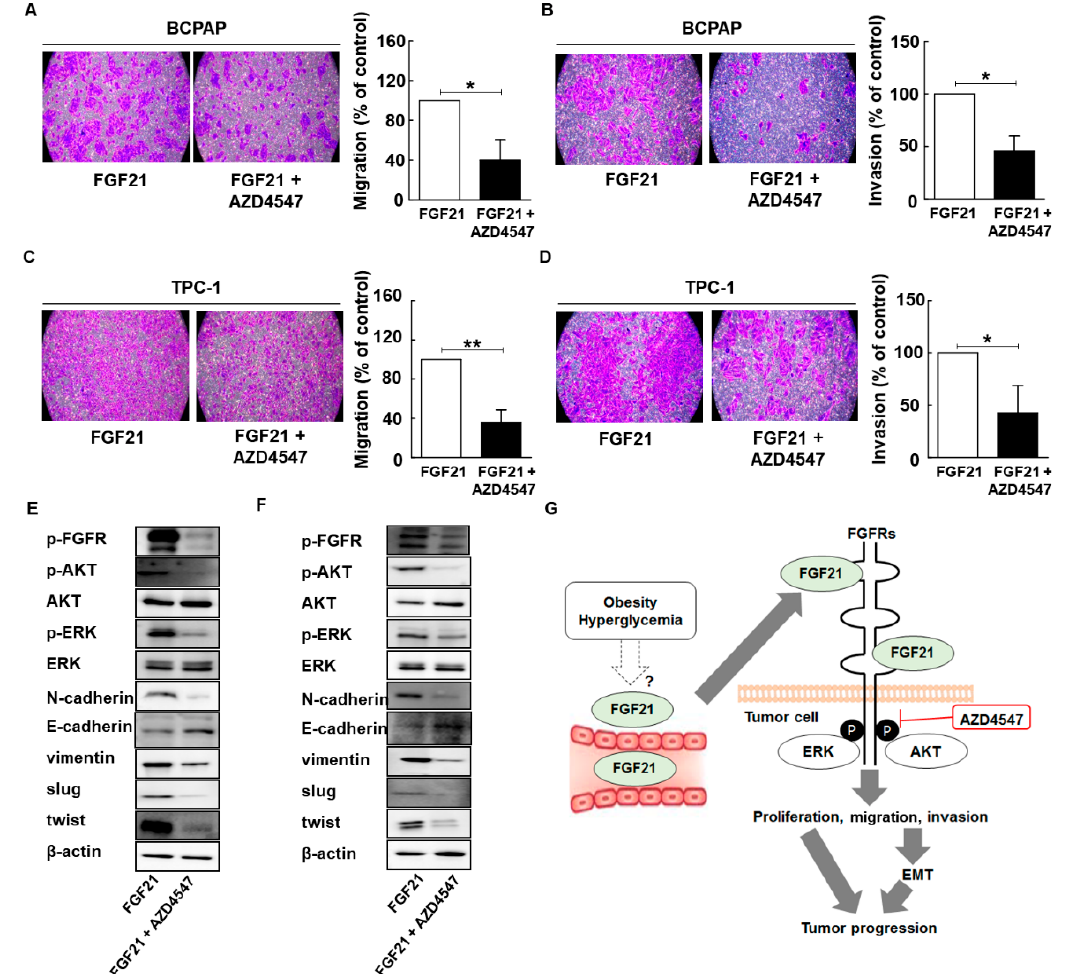
Figure 5. AZD4547 attenuates the e ff ects of FGF21 in thyroid cancer via downregulation of FGFR signaling. ( A ) The e ff ects of AZD45487 on the migration of BCPAP cells after treatment with only rFGF21 or rFGF21 and AZD4547 for 12 h, as determined by Transwell chamber assay. ( B ) The e ff ects of AZD4547 on the invasion in BCPAP cells in chambers coated with Matrigel after treatment with only rFGF21 or rFGF21 and AZD4547 for 12 h. ( C ) The e ff ects of AZD45487 on the migration in TPC-1 cells after treatment with only rFGF21 or rFGF21 and AZD4547 for 12 h, as determined by Transwell chamber assay. ( D ) The e ff ects of AZD4547 on invasion in TPC-1 cells in chambers coated with Matrigel after treatment with only rFGF21 or rFGF21 and AZD4547 for 12 h. ( E ) Representative images of Western blot analyses for the detection of p-FGFR, N-cadherin, E-cadherin, vimentin, p-AKT, AKT, p-ERK, ERK, SLUG, TWIST, and beta-actin in BCPAP cells treated only with rFGF21 or rFGF21 and AZD4547. ( F ) Representative images of Western blot analyses for the detection of p-FGFR, N-cadherin, E-cadherin, vimentin, p-AKT, AKT, p-ERK, ERK, SLUG, TWIST, and beta-actin in TPC-1 cells treated only with rFGF21 or rFGF21 and AZD4547. ( G ) Proposed model of the interaction between